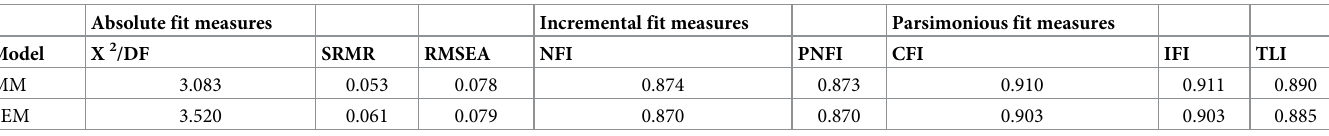
Table 5. Comparison measure model and structural model.